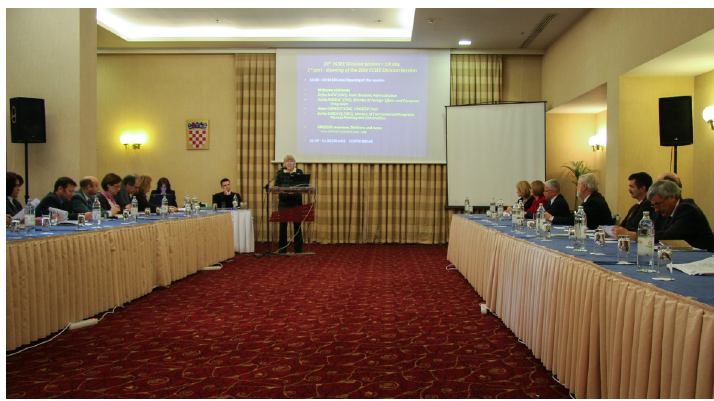
Fig. 4. 20th Session of the East Central and South­East Europe Division of the UNGEGN (Zagreb,